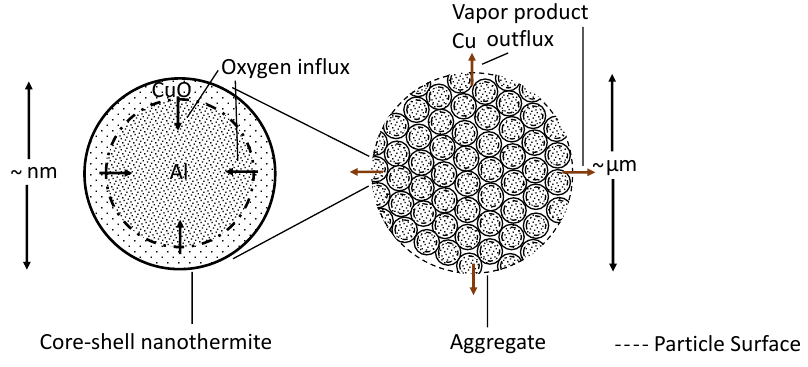
Figure 1. Illustration of the core–shell nanothermite and corresponding nanothermite agglomerate, which can disperse in the carrier phase for combustion.